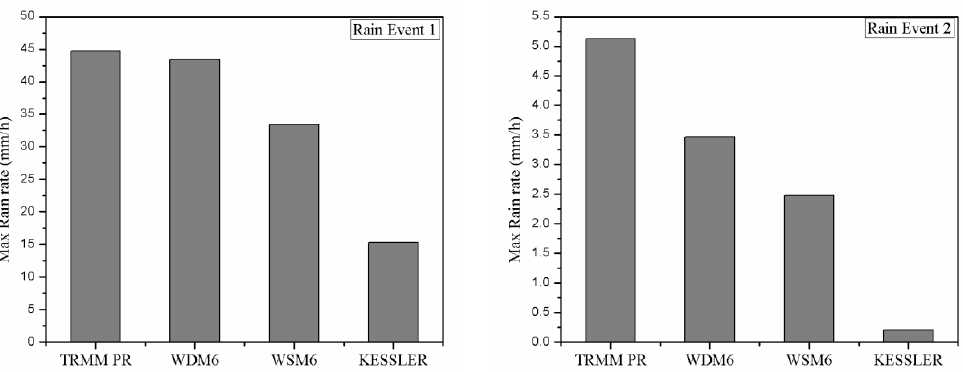
Figure 2. Comparison of TRMM PR near-surface rainfall with WRF simulated rainfall in mm/h. Again, WSM6 and WDM6 show a maximum rainfall of 2.48 mm/h and 3.47 mm/h. This comparison indicates that the WDM6 shows relatively good agreement with the